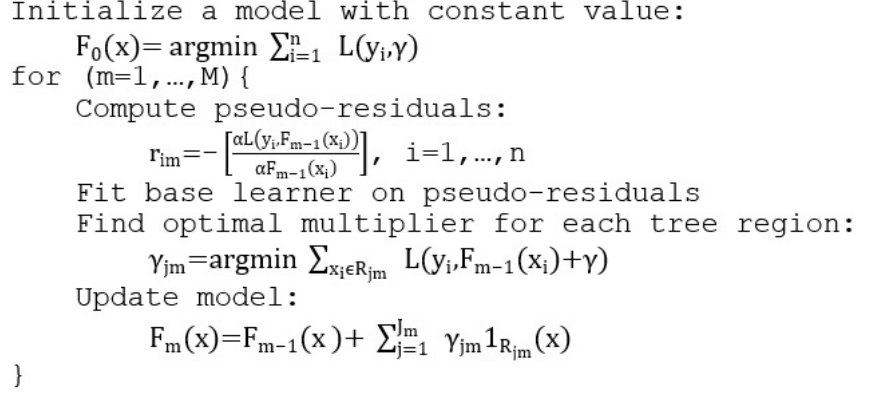
Figure 7. GBDT pseudocode. Figure 7. GBDT